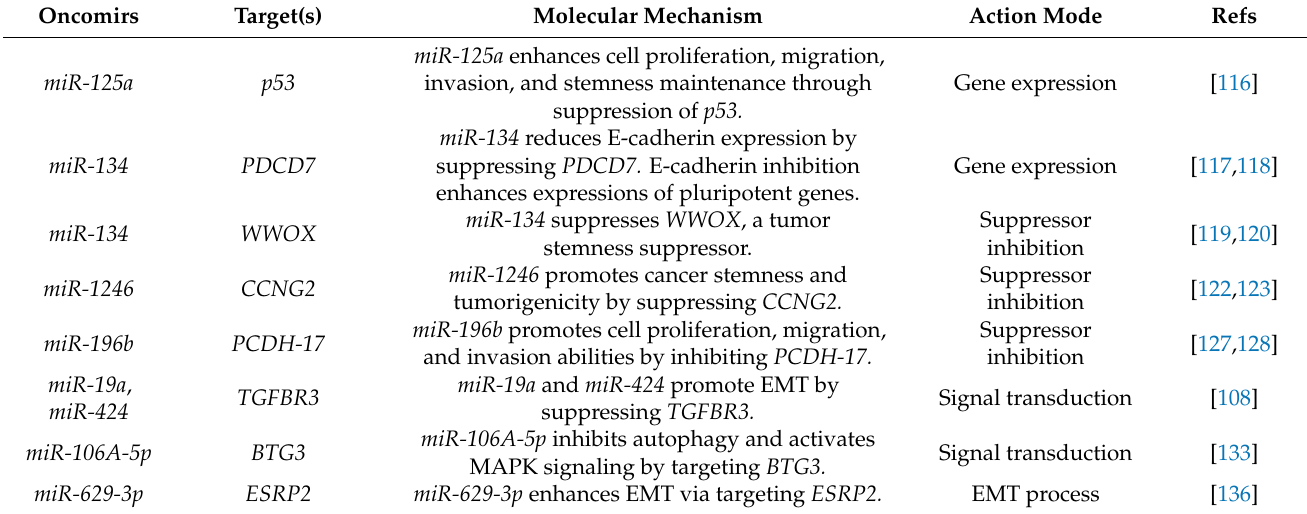
Table 1. miRNAs as oncomirs that are involved in the stemness of head and neck squamous cell carcinomas (HNSCCs).